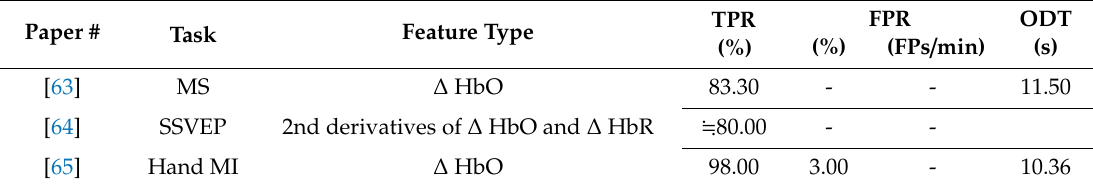
Table 6. List of near-infrared spectroscopy (NIRS)-based brain-switch studies. ∆ HbO, the change in oxygenated hemoglobin; (cid:52) HbR, the change in deoxygenated hemoglobin; MS, mental subtraction.